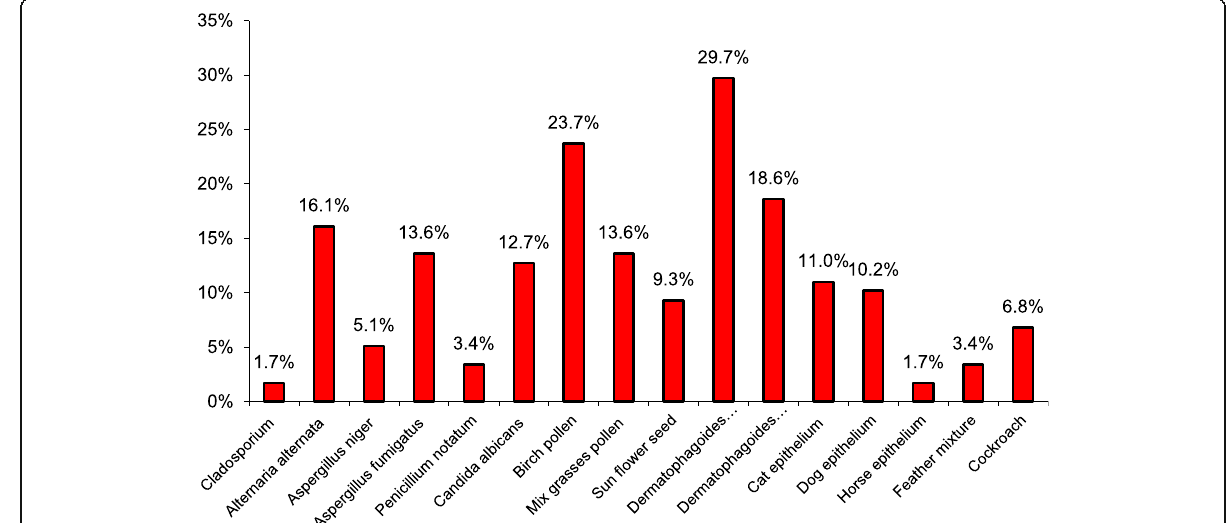
Fig. 1 Prevalence of positive-specific IGE to common aeroallergen among allergic rhinitis patients